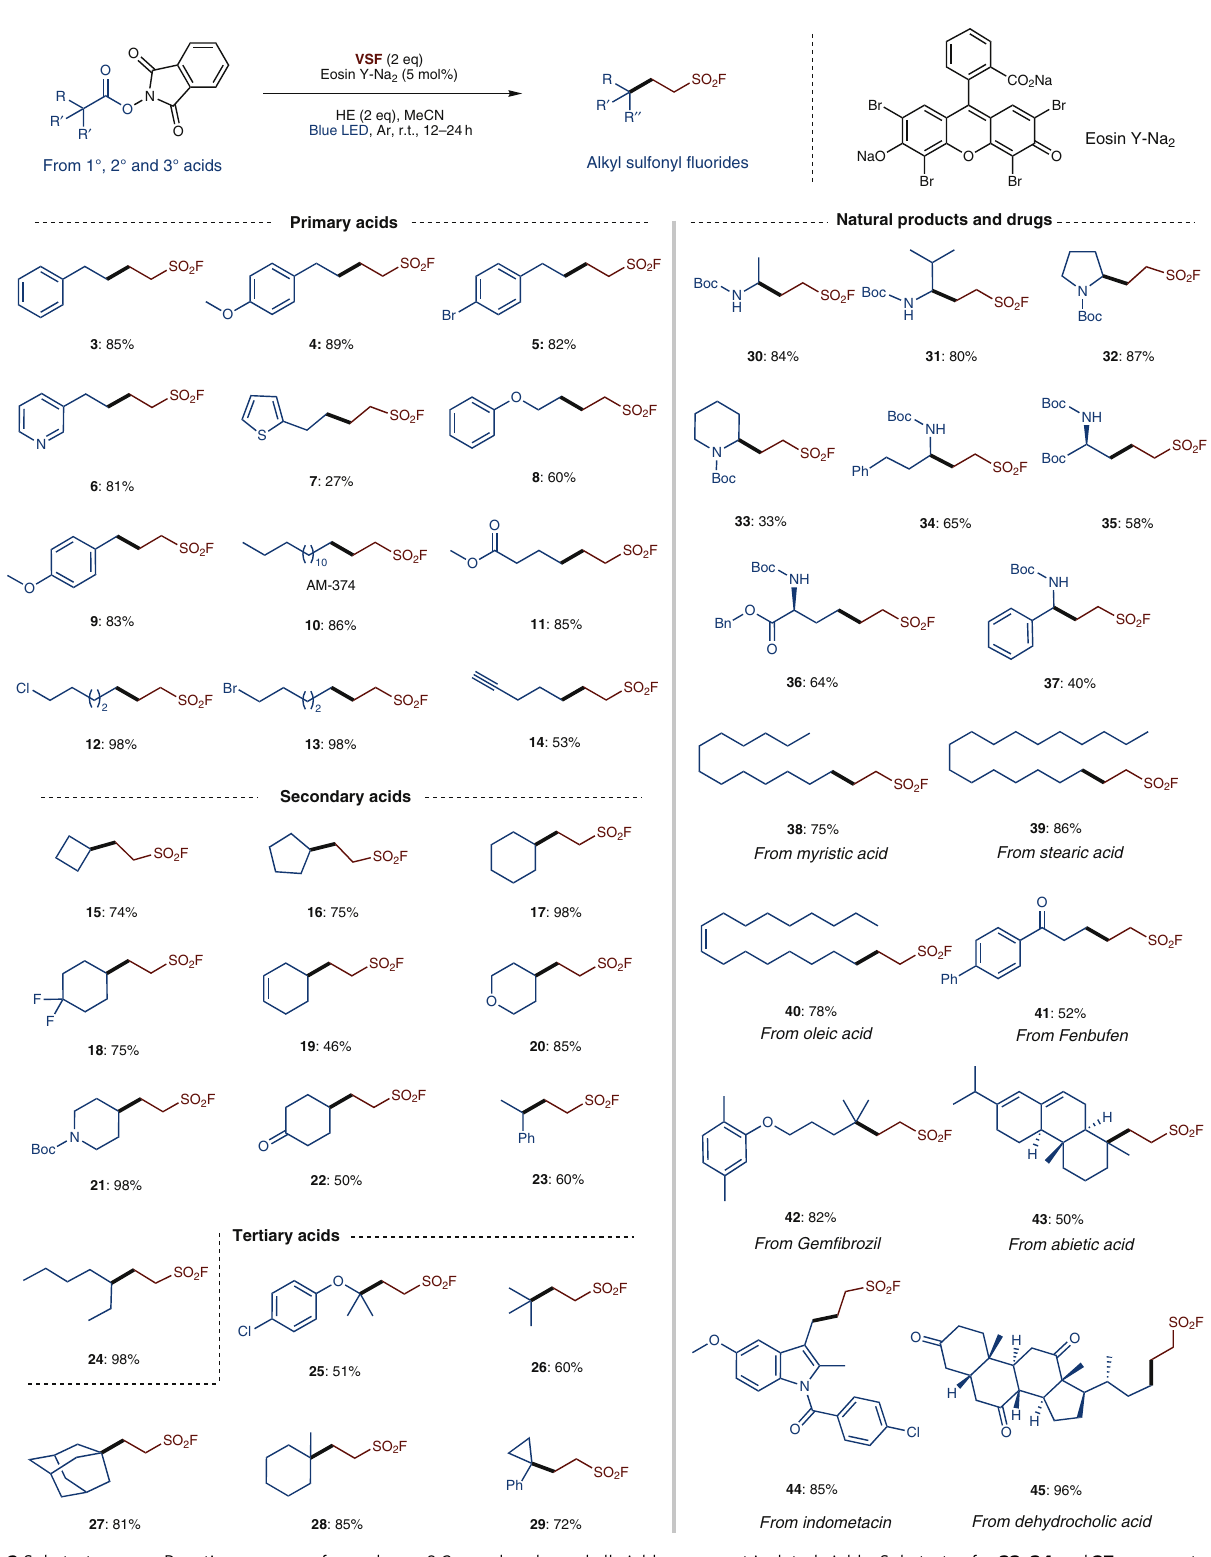
Fig. 2 Substrate scope. Reactions were performed on a 0.2 mmol scale, and all yields represent isolated yields. Substrates for 33 , 34 and 37 are unnaturally occurring amino acids contrast to the cases of DIPEA and TEA (for comparison, see and even till the end of the reaction, more than 90% of the Supplementary Figs. 1 and 2). The addition of DIPEA or TEA was excessive one equivalent of VSF remained intact. Moreover, even detrimental to the reaction, leading to a dramatic drop in mixing VSF and HE without 1 under the same irradiation yield (entries 15 and 16); further con fi rming this catalytic system conditions for 12 h showed no detectable loss of VSF, in sharp NATURE COMMUNICATIONS| (2019) 10:3752